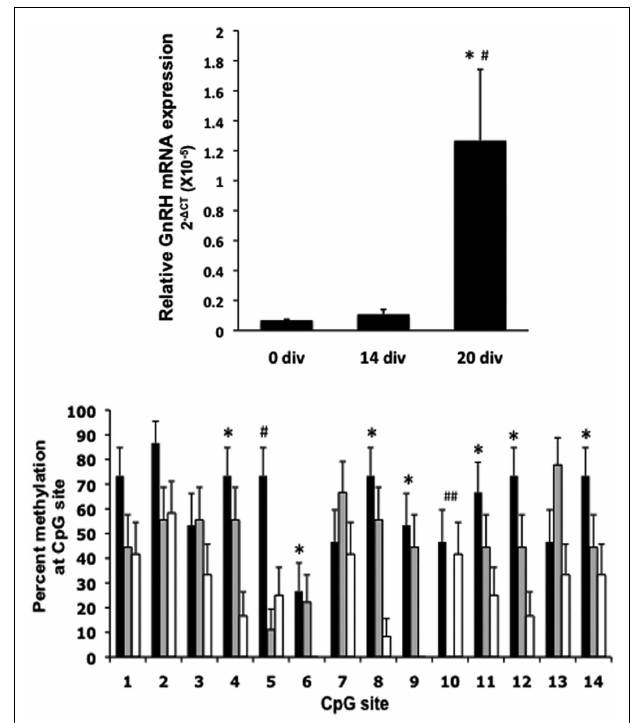
FIGURE 2 | Changes in GnRH mRNA levels and CGI methylation status during GnRH neuronal development. Top panel – total RNA was extracted from in vitro nasal placode cultures at 0, 14, and 20div ( n = 4 in all age groups). GnRH mRNA levels, measured by quantitative pcr, started to increase after 14div, reaching the highest level at 20div. (* P < 0.05 vs. 0div; # P = 0.05 vs. 14div). GnRH mRNA levels are relative to 18s in each sample and analyzed using the ∆ CT method. Bottom panel – GnRH neurons dissected from the nasal placode region of two rhesus monkey embryos at E36 and E37 were plated and then harvested on 0, 14, or 20div. DNA extracted from pooled samples (four cultures) at each time point was bisulfite sequenced. Percent changes in methylation at each CpG site on 0div ( black bars ), 14div ( gray bars ), and 20div ( white bars ) are shown. CpG methylation status was significantly higher at 0div compared with 20div at sites 4, 5, 6, 8, 9, 11, 12, and 14 (* P ≤ 0.01). CpG methylation status was significantly higher at 0div compared with 14div at site 5 ( # P < 0.05) and at 0div compared with 14div but not 20div at site 10 ( ## P <